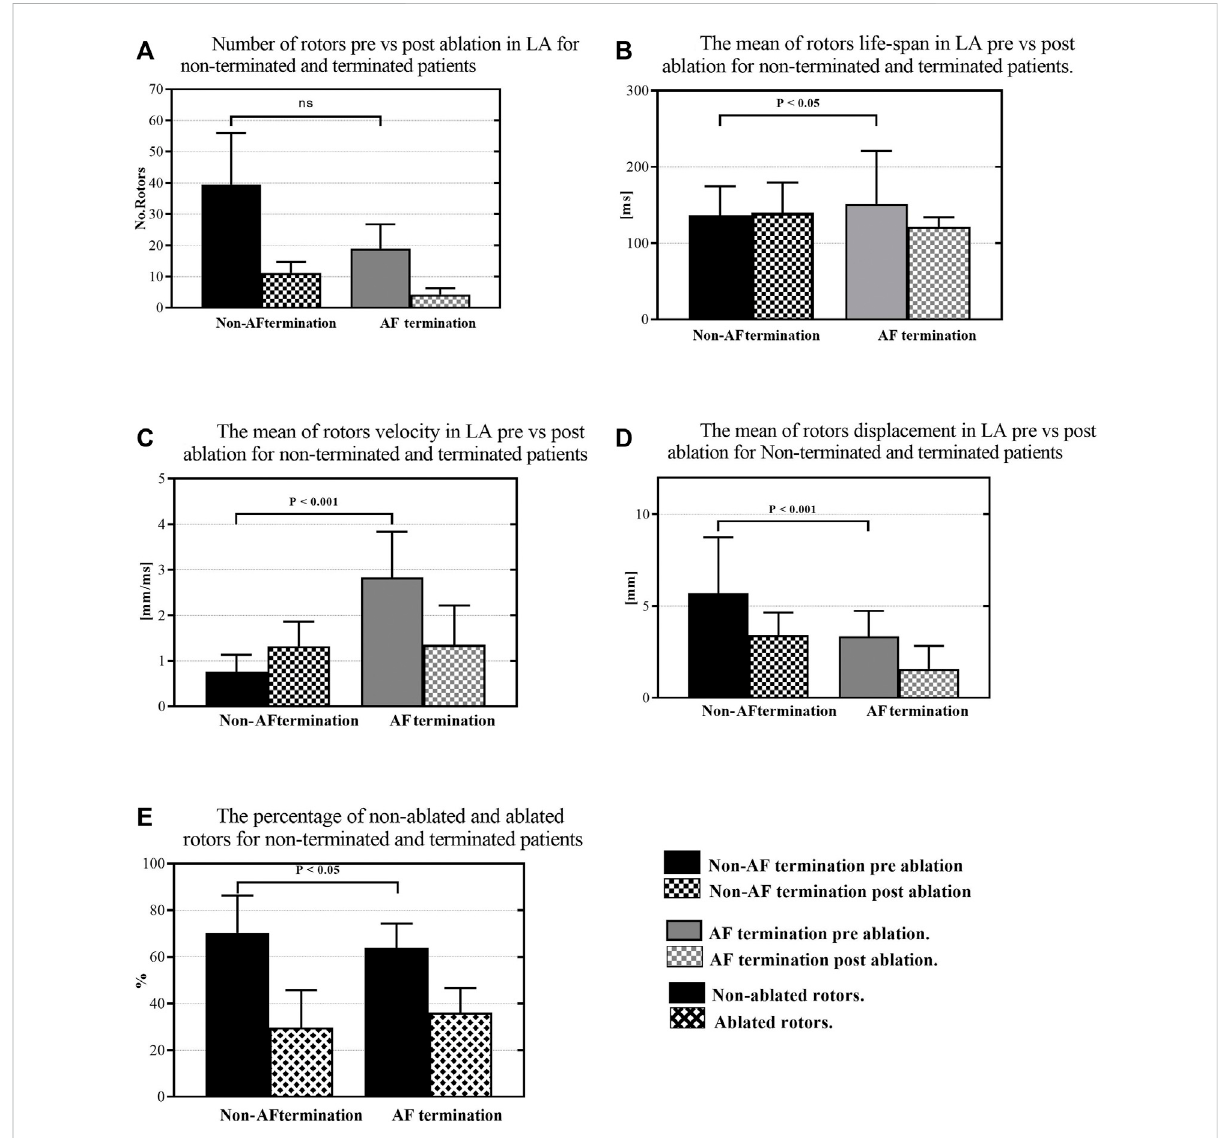
FIGURE 4 The response of the rotors to HDF ablation; (A) The number of rotors in pre-versus post-ablation for non-terminated and terminated patients. (B) The mean of the rotors life-span in pre-versus post-ablation for non-terminated and terminated patients. (C) The mean of the rotors ’ velocity in pre-versus post-ablation for non-terminated and terminated patients. (D) The mean of the rotor displacement in pre-versus post-ablation for non- terminated and terminated patients. (E) The percentage of overall non-ablated and ablated rotors in non-terminated and terminated